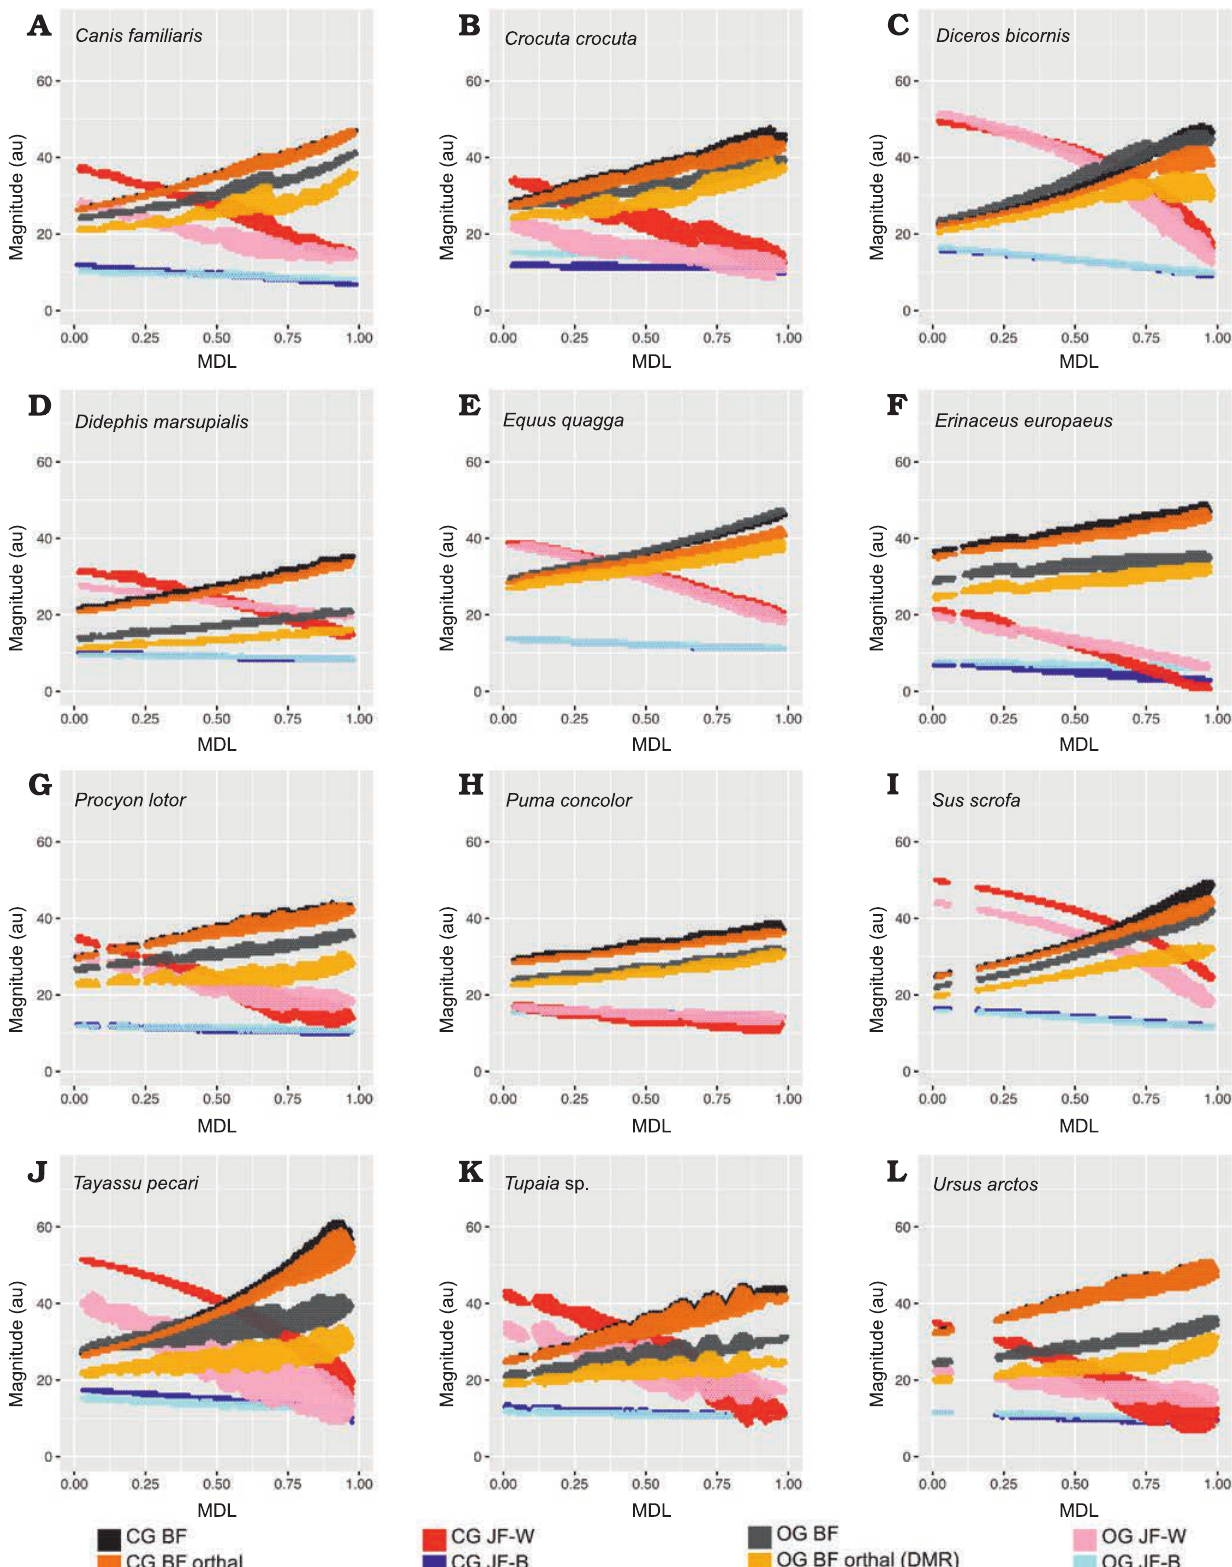
Fig. 9. 2D histograms showing distribution of estimated force magnitudes for closed gape (CG) and open gape (OG) mandible positions (on ordinate), as a function of mesiodistal location (MDL; on abscissa). A . Canis familiaris . B . Crocuta crocuta . C . Diceros bicornis . D . Didephis marsupialis . E . Equus quagga . F . Erinaceus europaeus . G . Procyon lotor . H . Puma concolor . I . Sus scrofa . J . Tayassu pecari . K . Tupaia sp. L . Ursus arctos . Abbreviations: BF, bite force; JF-W/B, working-/balancing-side joint